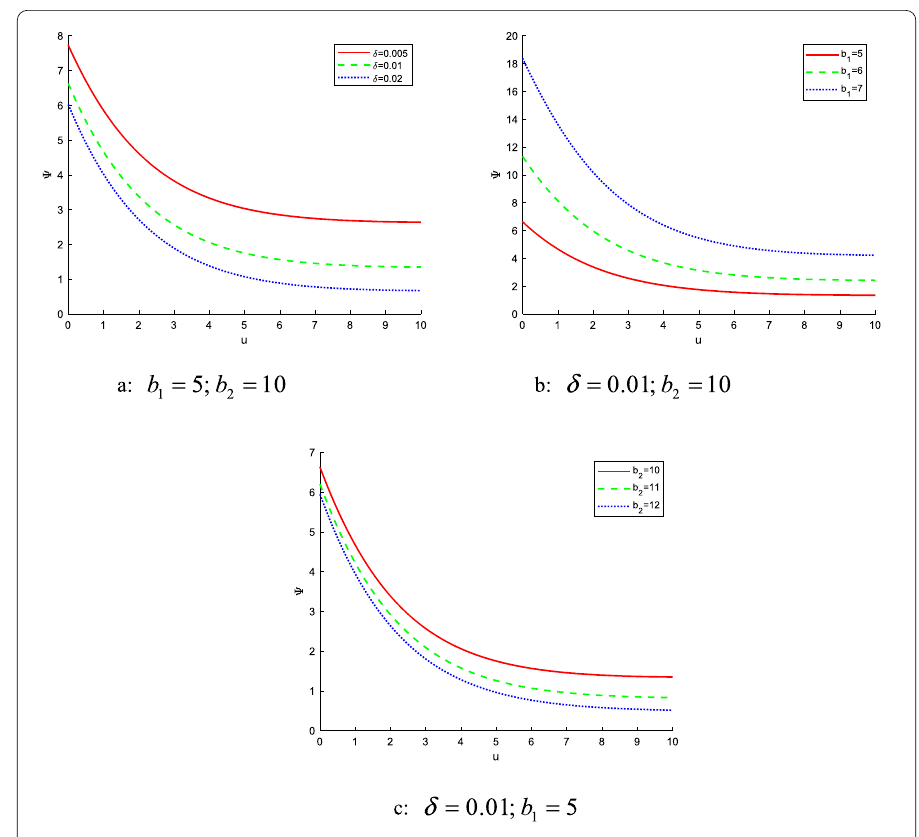
Figure 3 The expected discounted capital injection until